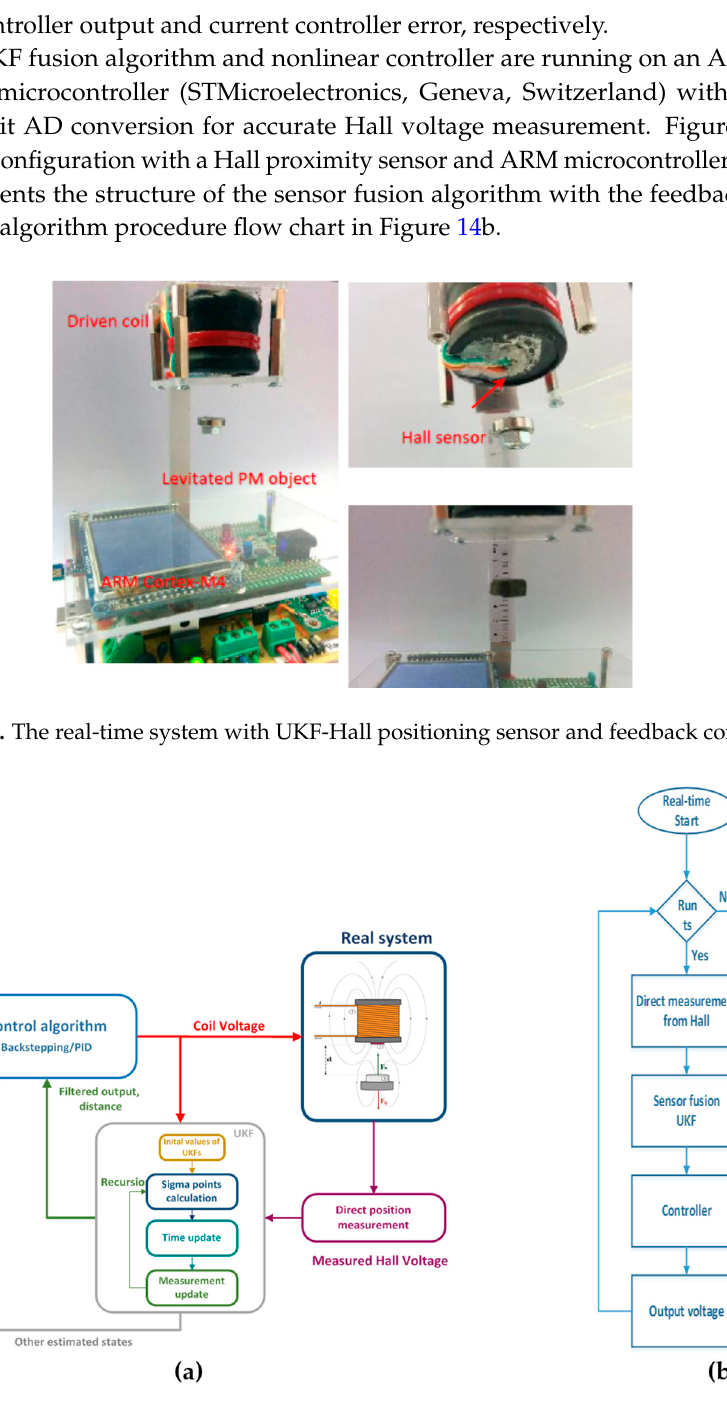
Figure 14. ( a ) Schematic of an algorithm structure and ( b ) Flow chart of real time algorithm execution.